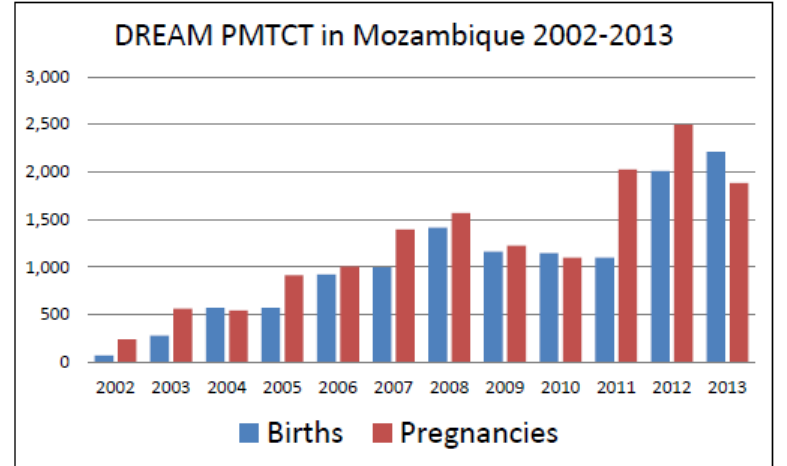
Figure 2. Patients receiving care at DREAM centers in Mozambique over the